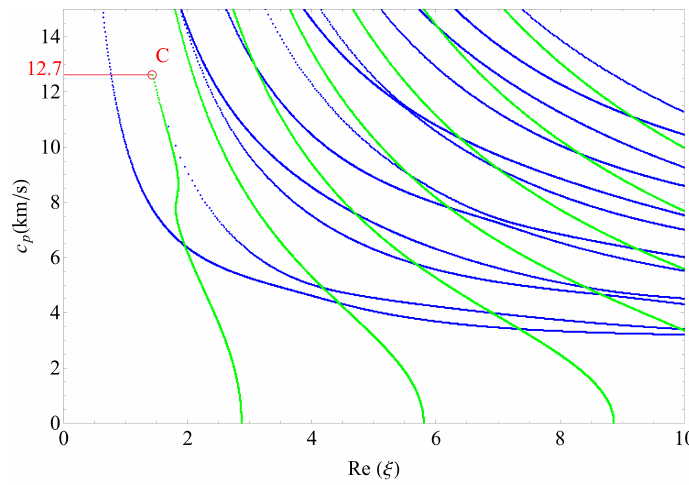
Figure 18. Phase velocity spectra ( n = 2).